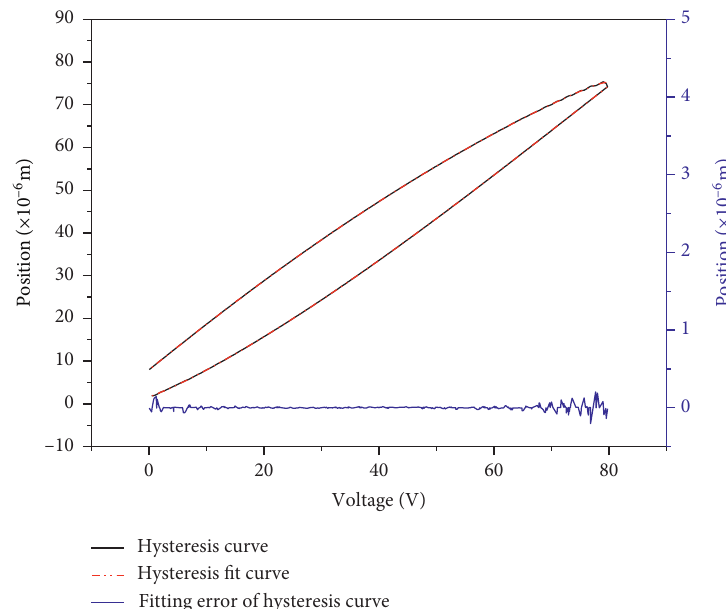
Figure 8: Modeling results of the BP algorithm based on WOA.